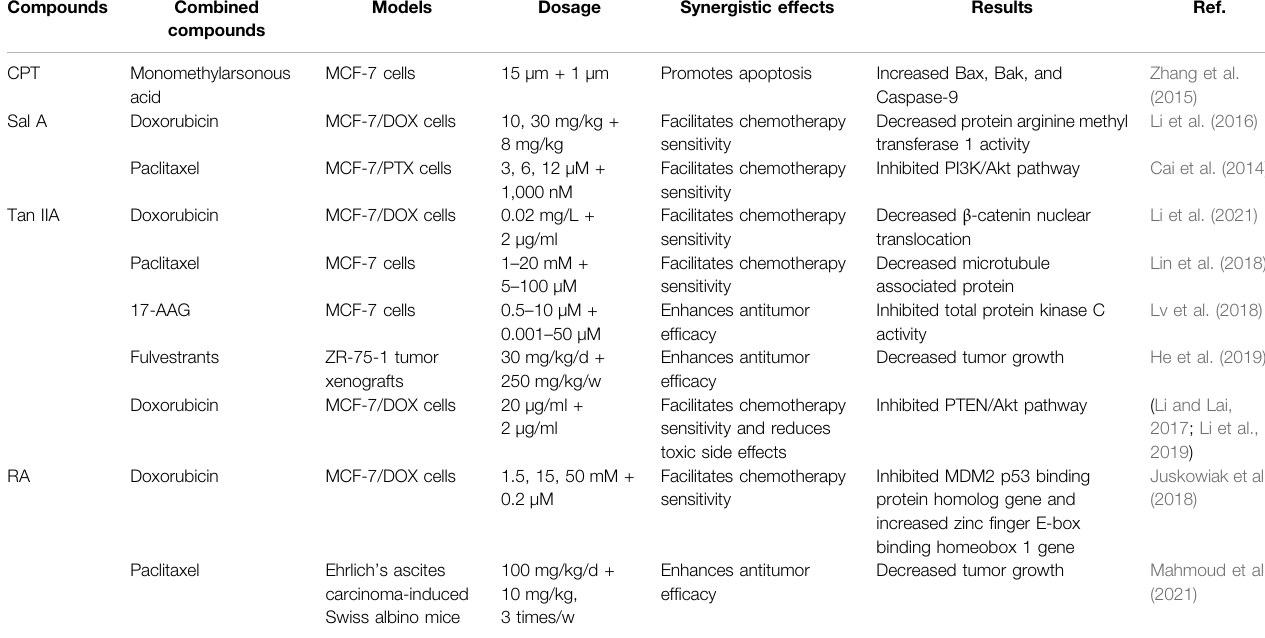
TABLE 1 | The synergistic effects of active compounds in S. miltiorrhiza for breast cancer treatment. Compounds